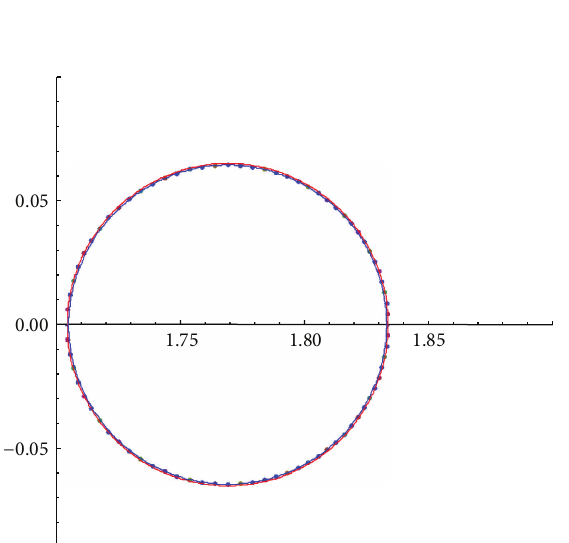
Figure 7: Corona delimiting the bulb of period two in the head.